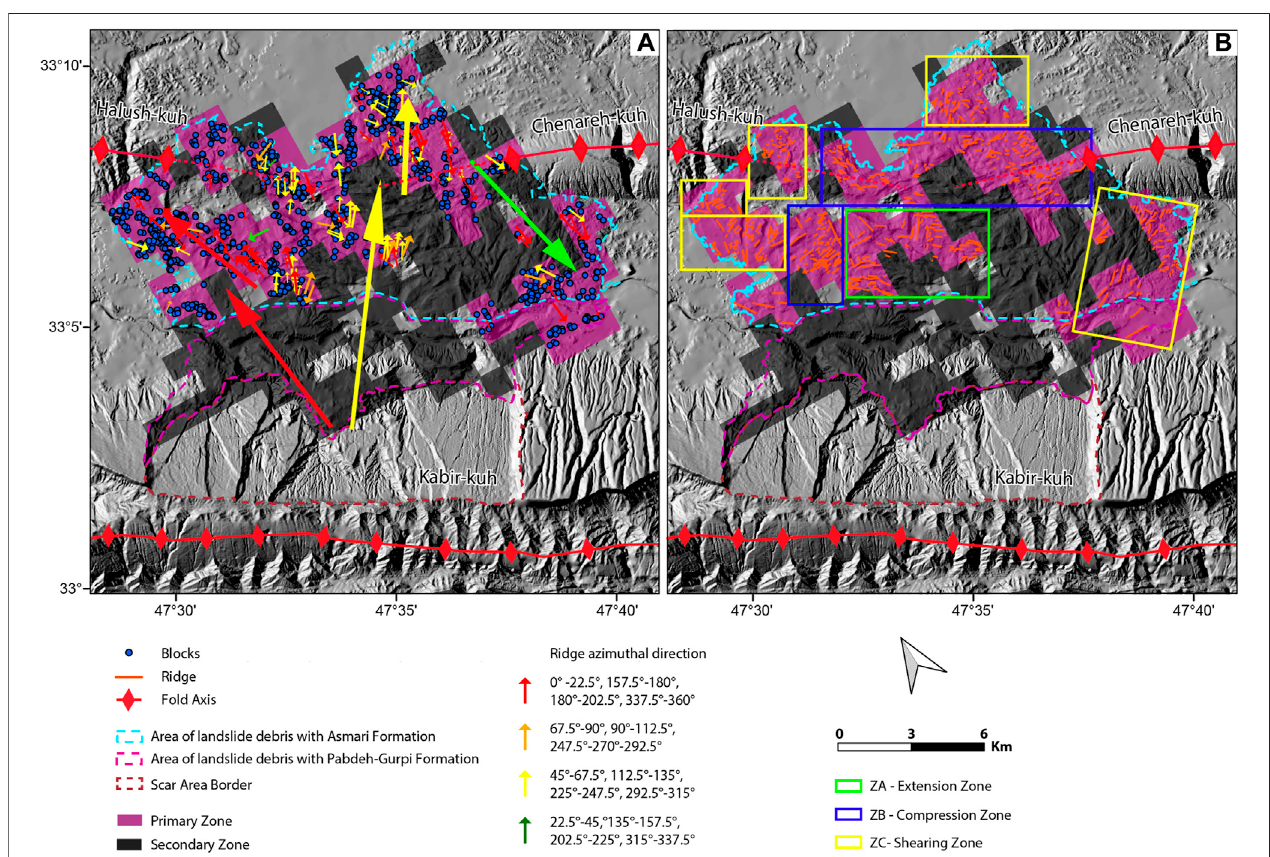
FIGURE9| Emplacement kinematics model ofSeymareh landslide. Locationsof (A) blocks and (B) ridges clipped by primary zones. The ridge azimuthal direction is reported for the interpretation of extension, compression, and shearing zones. The coordinate reference system is WGS84.